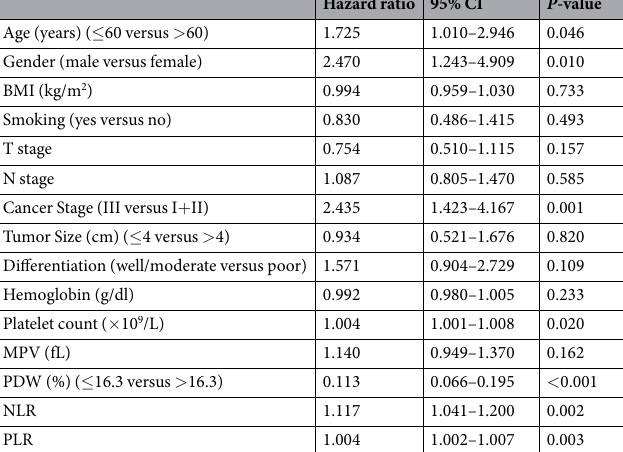
Table 3. Univariate analysis of overall survival in patients with lung cancer. PDW, platelet distribution width; BMI, body mass index; MPV, mean platelet volume; NLR, neutrophil-to-lymphocyte ratio; PLR, platelet-to- lymphocyte ratio.